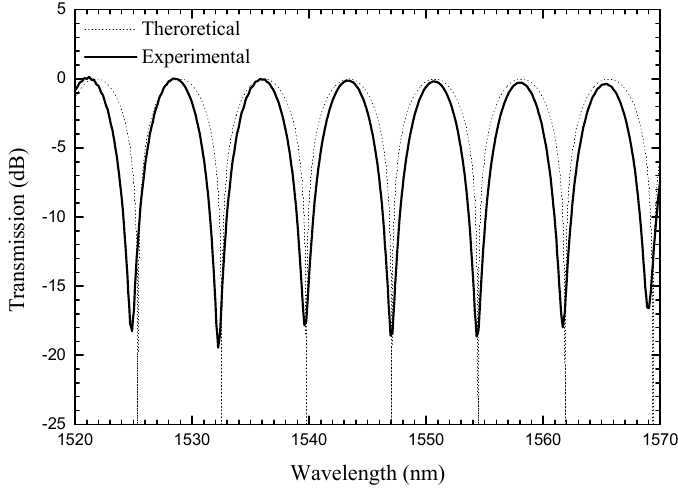
Figure 3. Transmission spectra of the Hi-Bi